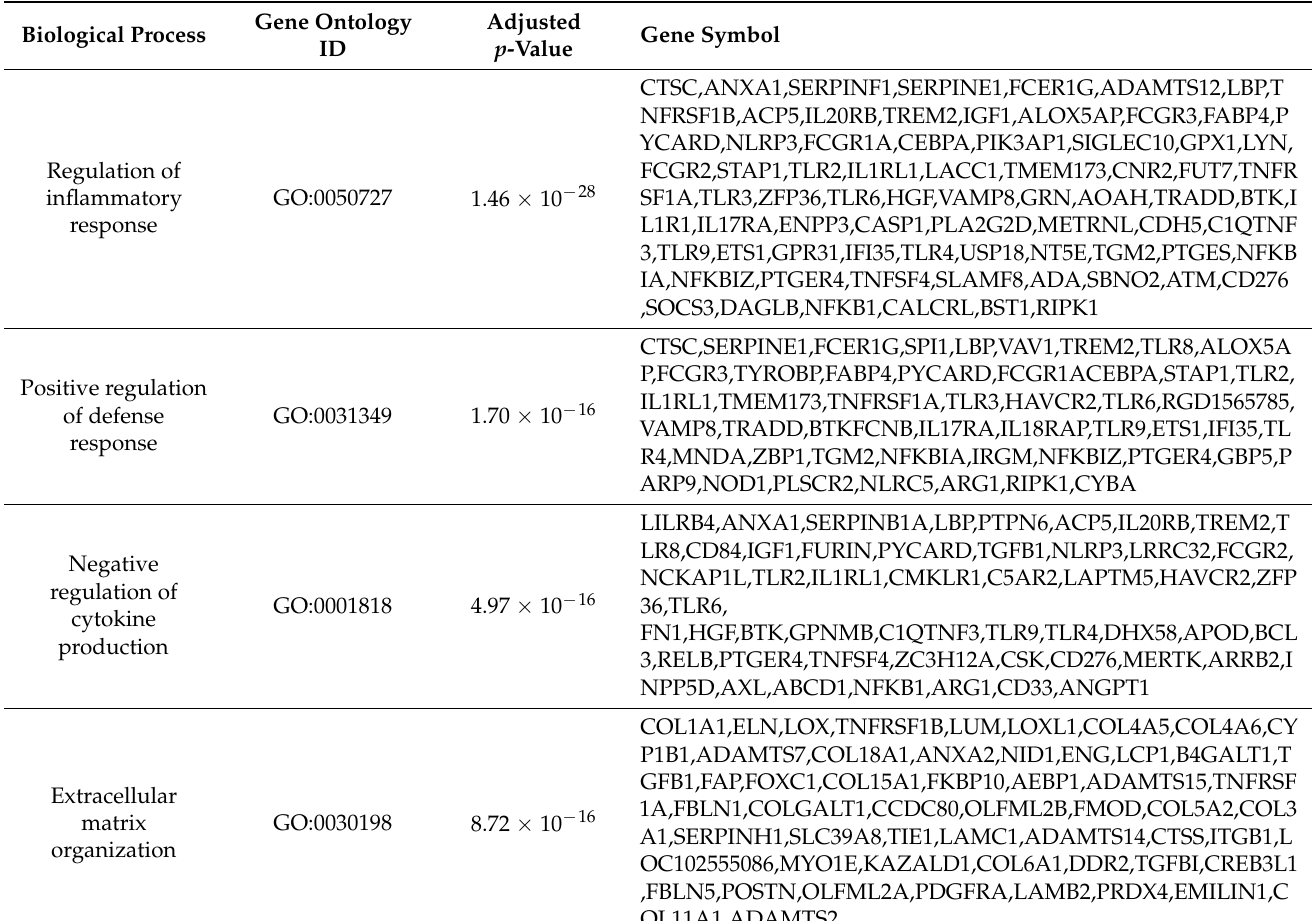
Table 2. GO enrichment analysis and biological processes for the downregulated genes in NPC- CM(M)-treated ischemic rat